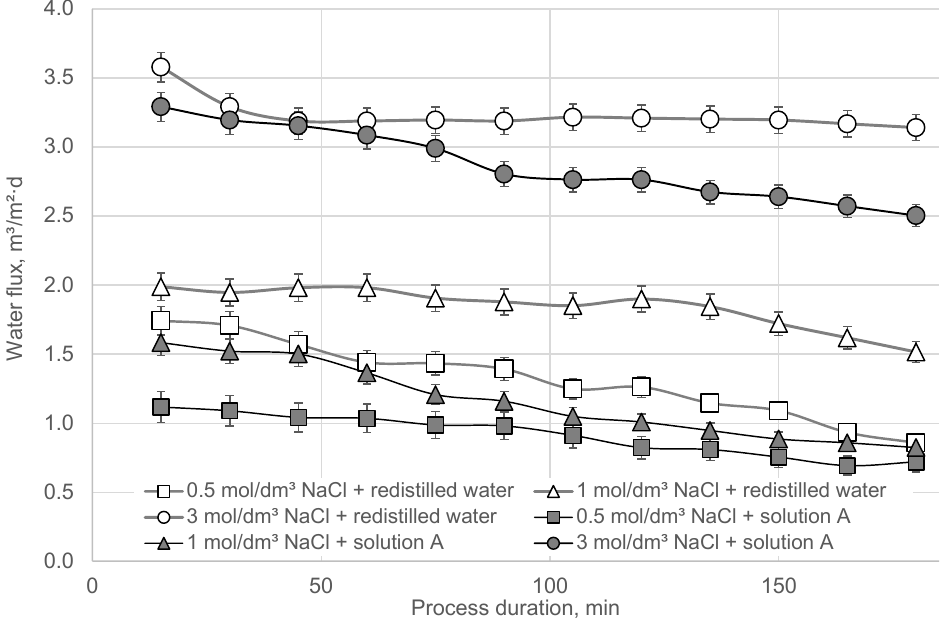
Figure 4. Water flux time dependence of FO for different concentrations of NaCl in the receiving solution for redistilled water and solution of the digestate after struvite precipitation.